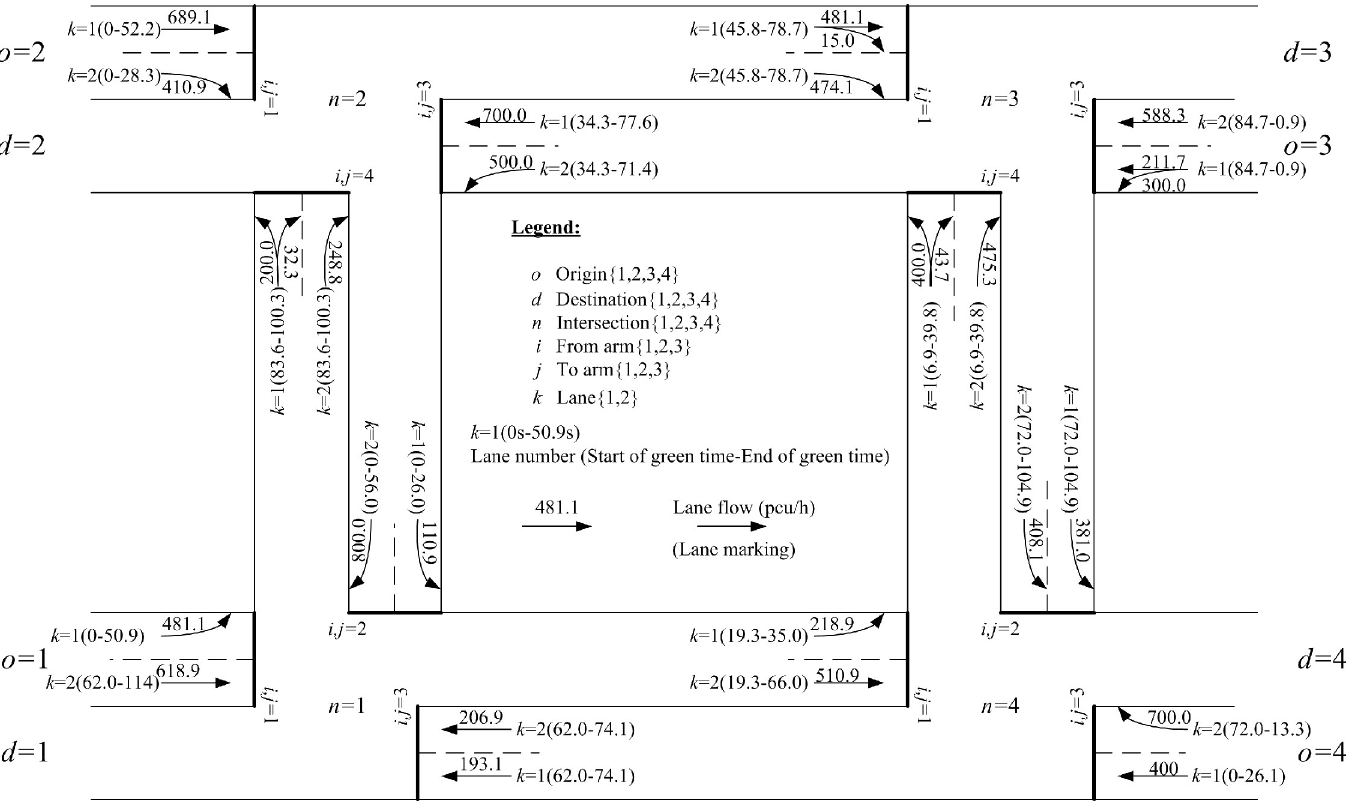
= z ¼ o ¼ 2 ; d ¼ 4 ; h o ; d ¼ 1